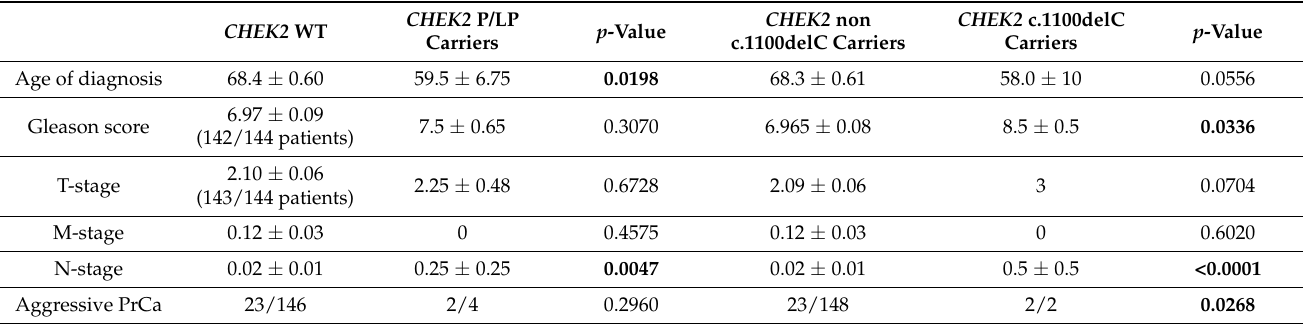
Table 3. Clinicopathological characteristics of carriers of P/LP CHEK2 variants and noncarriers. Significant p -values are depicted in